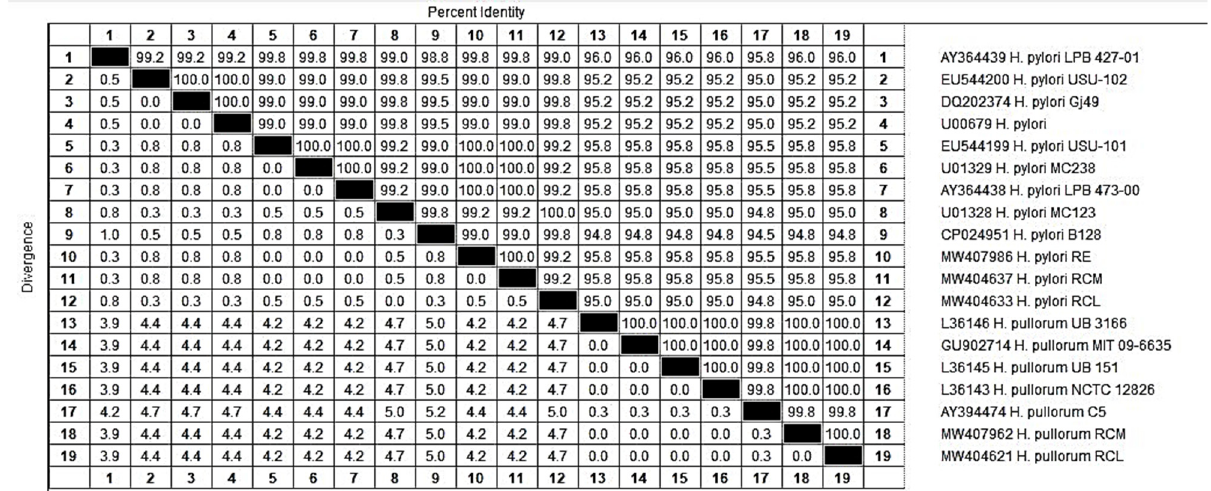
Figure 3. Identity percentages detected through the homology search (BLAST-N) of the 16S rRNA sequences of the isolated H . pylori and H . pullorum.